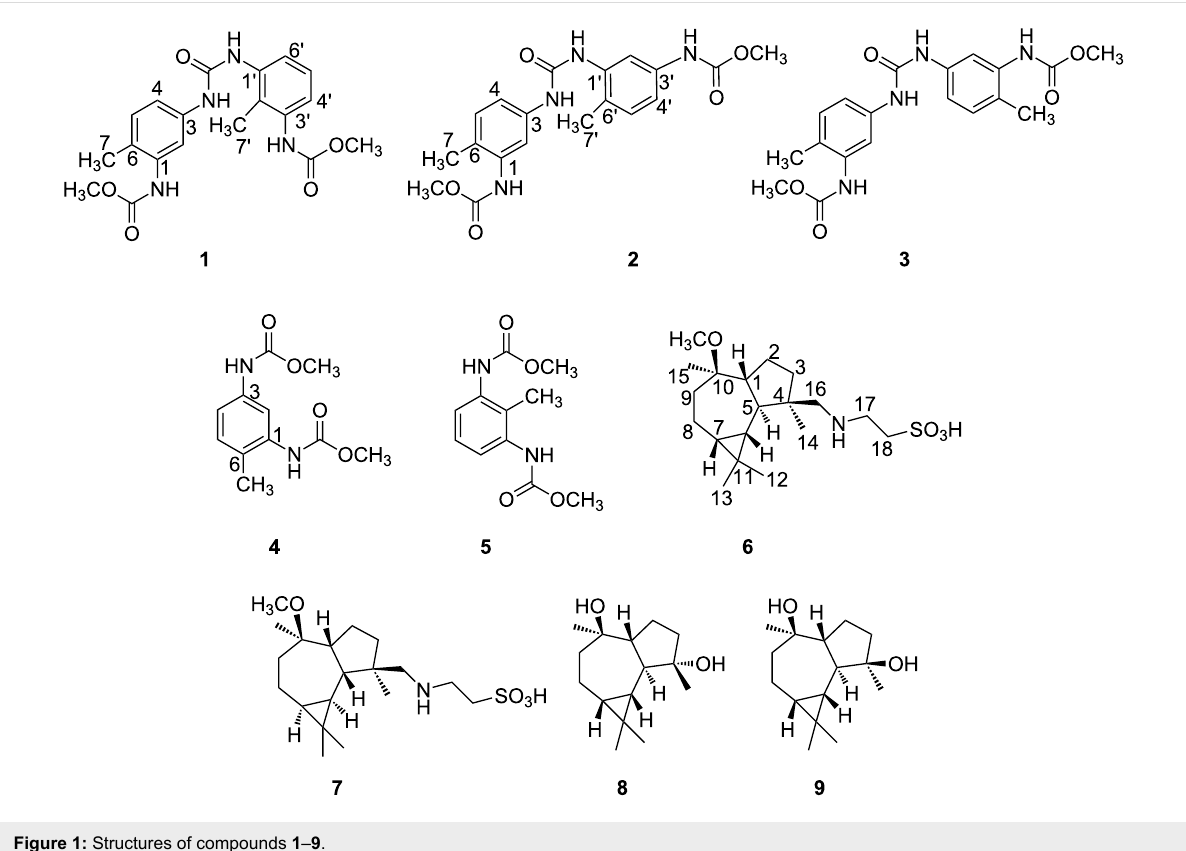
Figure 1: Structures of compounds 1 – 9